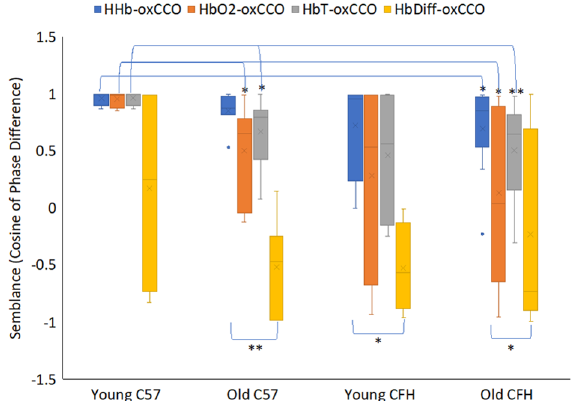
Figure 4. The association between mitochondrial and choroidal signals during slow-wave oscillations is significantly reduced with age and in CFH −/− . Oscillatory phase differences (wavelet semblance) between hemoglobin (HHb, HbO 2 , HbT and HbDiff) and oxCCO signals in different experimental groups averaged over 1 h. The mean semblance for each animal is calculated at the specific slow-wave oscillation frequency for that animal (the most predominant peak on the FFT signal). A semblance of + 1 indicates that the hemoglobin signal oscillations are perfectly in phase with the oscillations in the oxCCO signal, and − 1 that they are perfectly antiphase with oxCCO oscillations. In young C57 mice (n = 4), oscillations in oxygenated and deoxygenated hemoglobin (HbO 2 and HHb) and total hemoglobin (HbT) are in phase with mitochondrial oscillation (oxCCO). The phase difference between oxygenated and total hemoglobin (HbO 2 and HbT) with metabolism (oxCCO) are significantly greater in old C57 (n = 7) and old CFH −/− (n = 9) mice compared to young C57 mice, but not in young CFH −/− mice (n = 4). In all groups HHb oscillations follow the mitochondrial oscillations more closely than other hemoglobin signals, and except for young C57s, there is a significant difference between the semblances of HHb-oxCCO with HbDiff-oxCCO. Asterisks are significant differences from HbDiff-oxCCO semblance. Data are mean ± standard error (*p < 0.05, **p < 0.005, ****p < 0.00005, *****p < 0.00001).